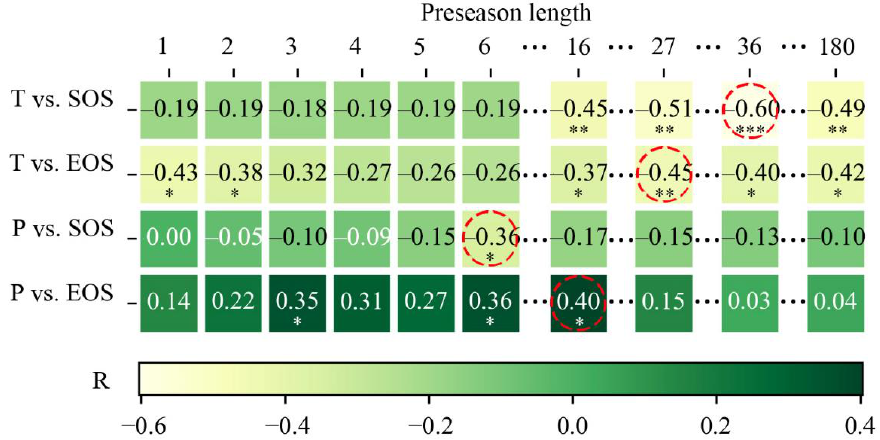
Figure 2. The partial correlation coefficient matrix for pixel in row i, column j (*: p -value<0.05, **: p -value < 0.01, ***: p -value < 0.001.). T and P stand for preseason temperature and preseason precipitation. The red dotted circle represents the maximum value of each row, and its corresponding preseason length is the optimal time scale.